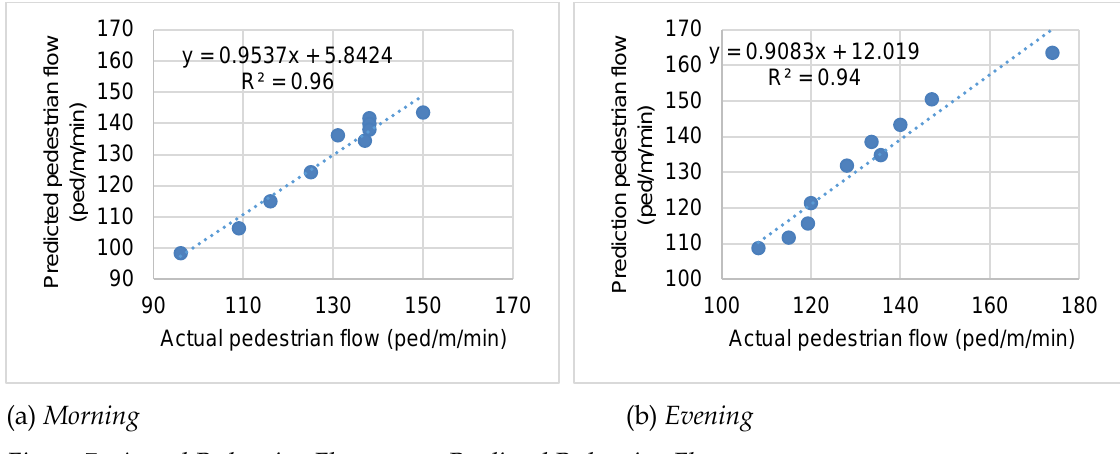
Figure 7. Actual Pedestrian Flow versus Predicted Pedestrian Flow The prediction accuracy of the above-mentioned relationships is presented in Table 8. The variation has been observed varying within ± 7% for evening flows and ± 4% for morning flows, which is quite low. This indicates towards good predictive power of the two models. In general, flows were underestimated by the models. Table 8. Prediction Accuracy of PPPF - Time